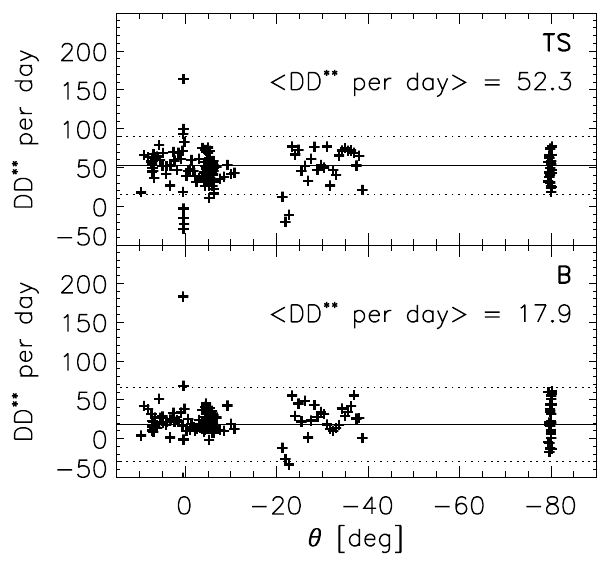
Fig. 6. Distribution of DD ?? per day normalized on 400km/s and 1AU versus θ ; average (solid) and standard deviation (dotted) are